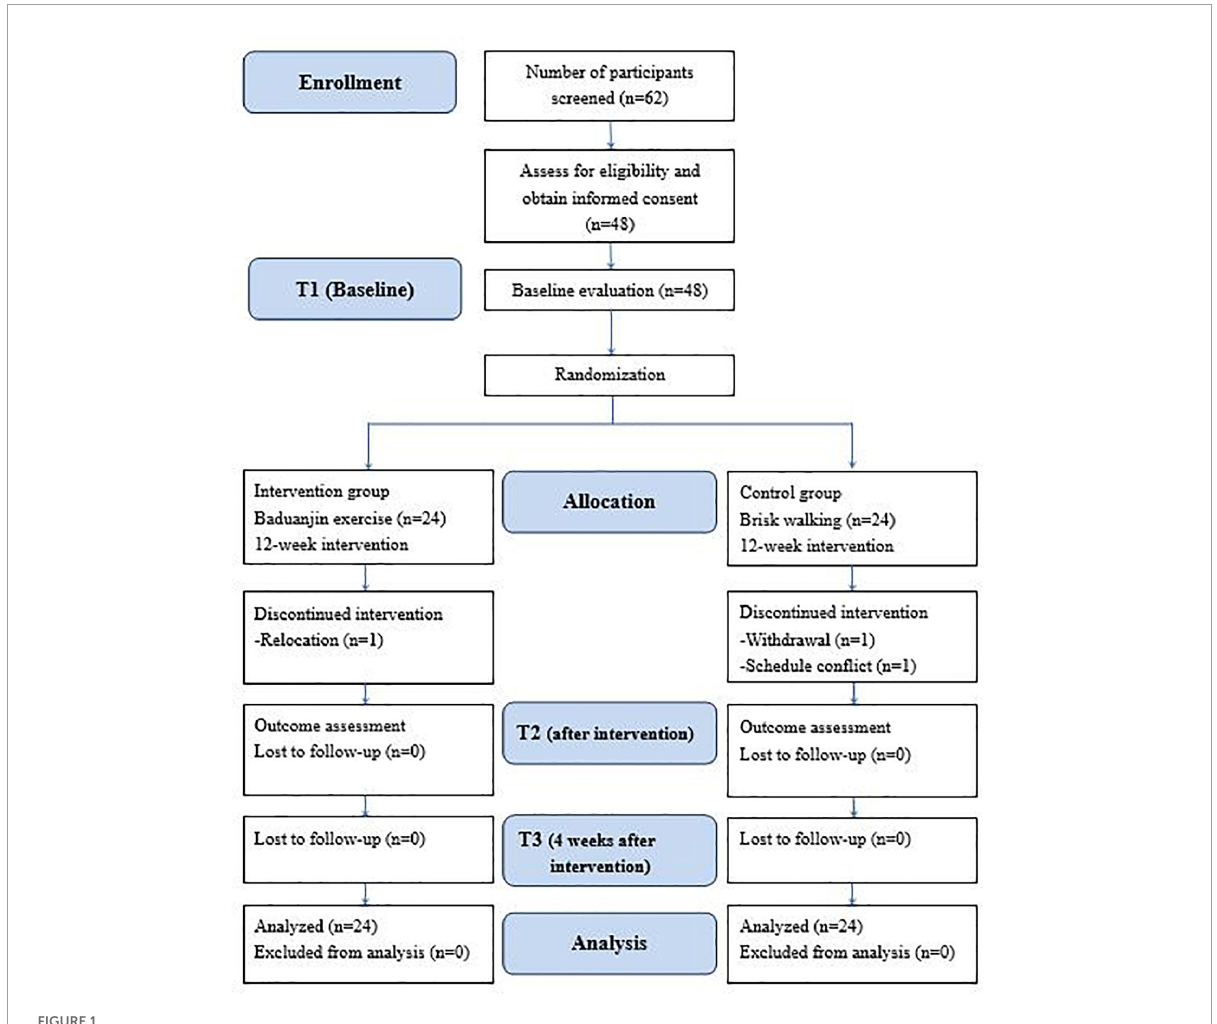
FIGURE1 Flow diagram of the